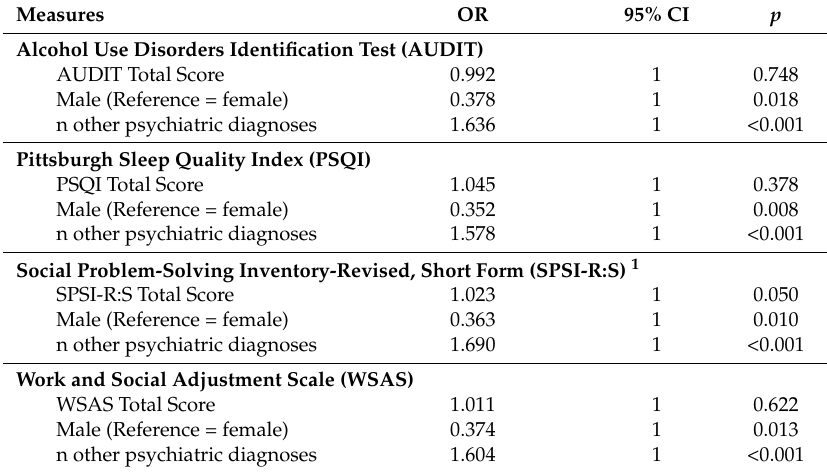
Table 3. The odds of meeting PTSD criteria by functional measures (i.e., alcohol, sleep, social problem-solving, and work and social adjustment) adjusting for gender and number of other psychiatric